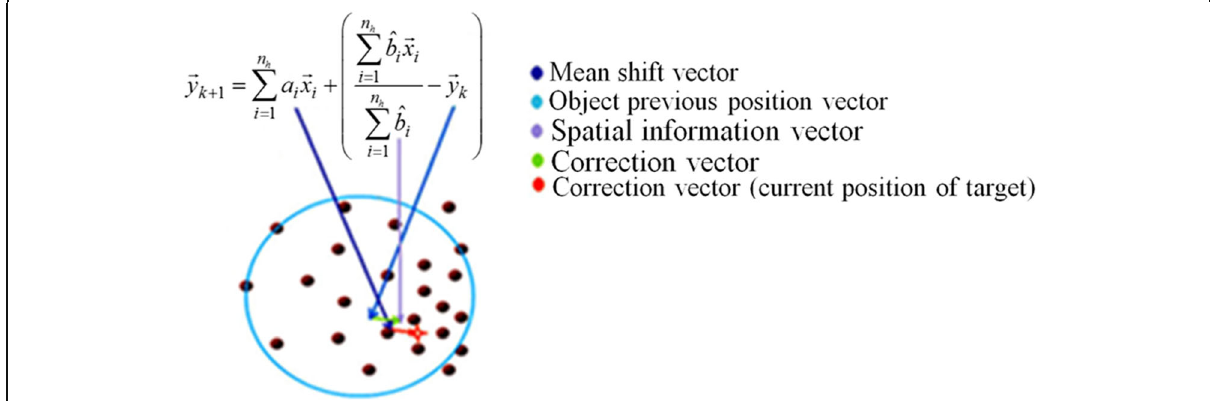
Fig. 12 Operation of proposed algorithm in finding denser points in the condition that mean-shift algorithm tracks the